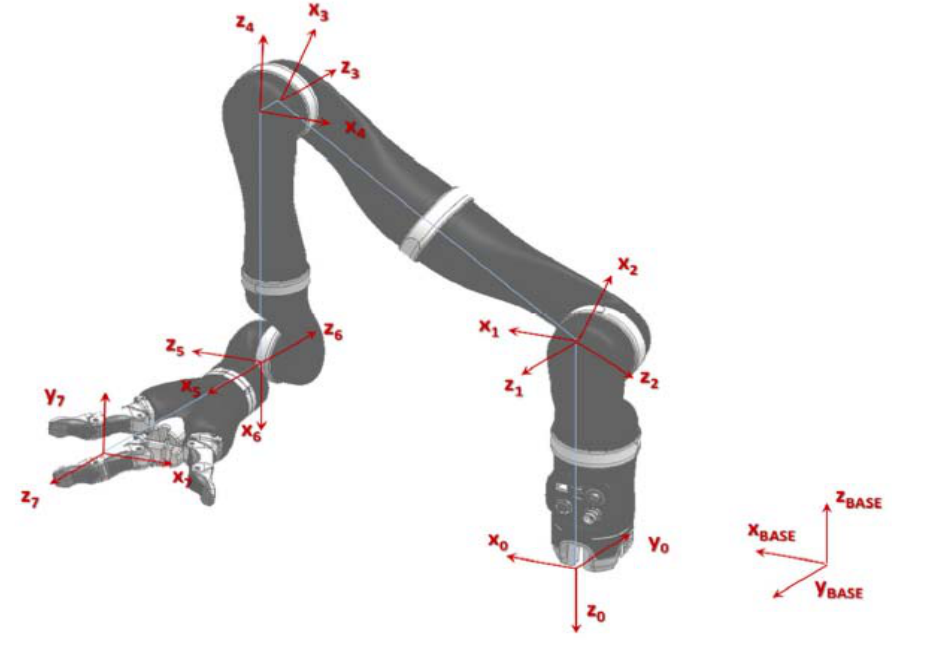
Figure 1. JACO2 robot coordinate system. Table 1. D-H parameters of the JACO2 robot.